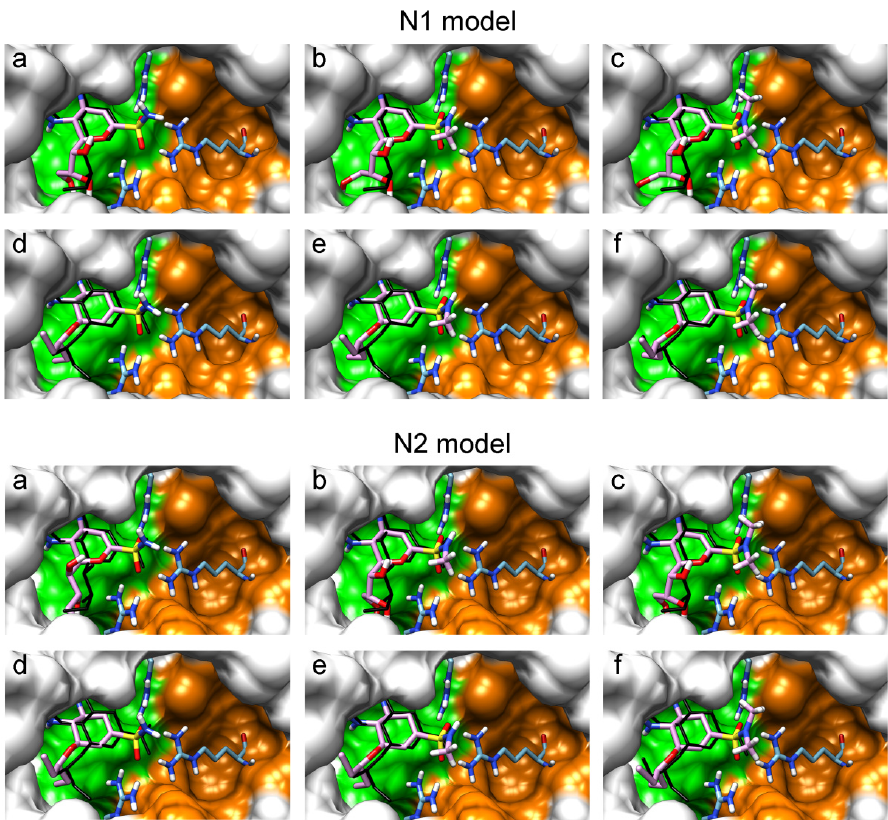
Figure 4. Positions of sulfonamide analogues of zanamivir ( a – c ) and oseltamivir ( d – f ) in N1 and N2 neuraminidase models. Compounds containing terminal ( a , d ), monosubstituted ( b , e ) and disubstituted ( c , f ) sulfonamide groups are shown. The sialic acid cavity is shown in green, and the 430-cavity in orange. The coordinates of zanamivir and oseltamivir carboxylate taken from the available crystal structures 3b7e and 3ti6 are shown in black. Int. J. Mol. Sci. 2021 , 22 , 13112